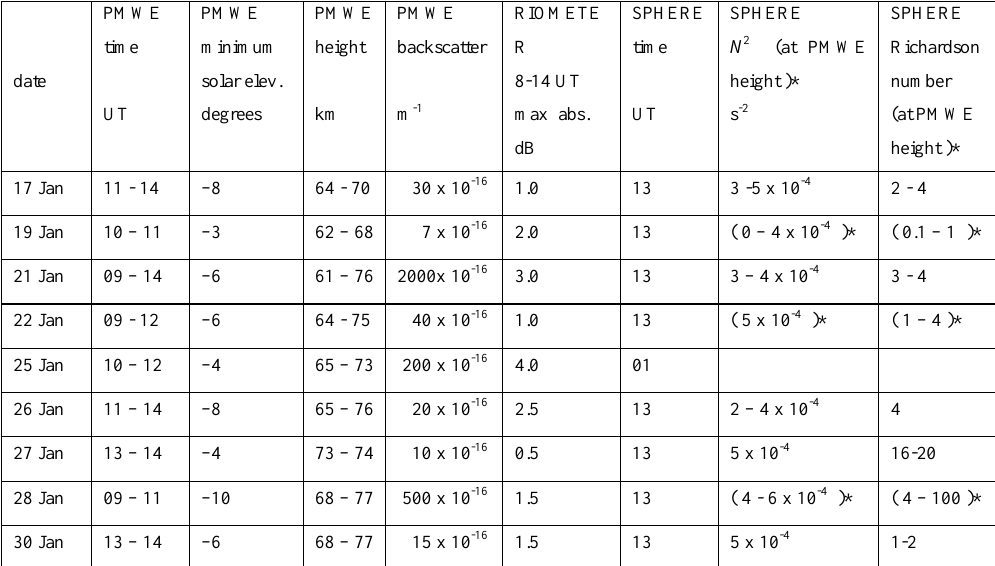
Table 1. Observations of PMWE using ESRAD, cosmic noise absorption from the Abisko riometer (30MHz) and squared buoyancy frequency ( N 2 ) and Richardson number from MaCWAVE falling-spheres during January 2003. ∗ indicate occasions when there was no PMWE visible exactly at the time of the rocket flight – comparison is then made with PMWE seen 1–2h